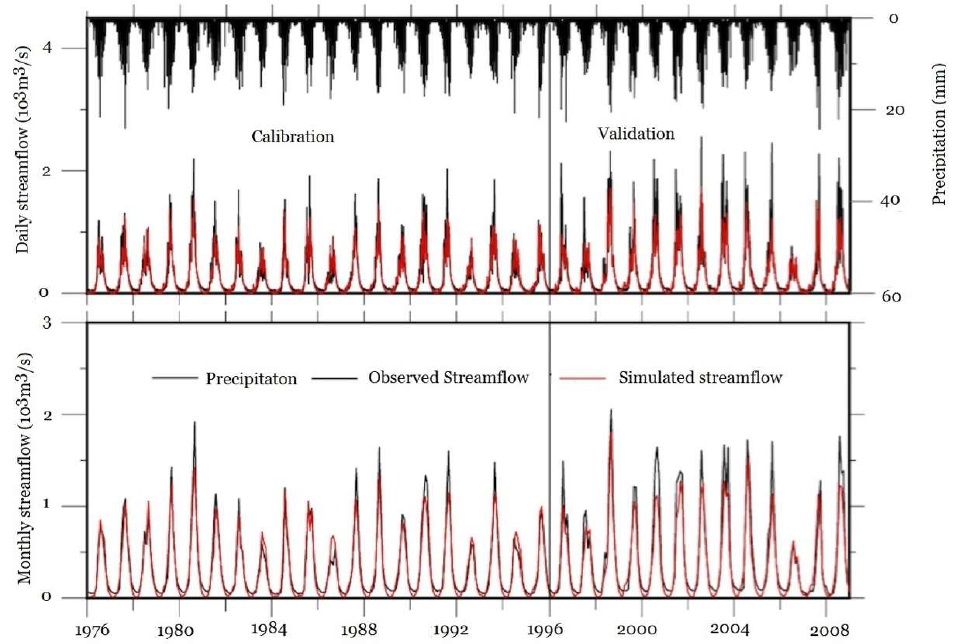
Figure 8. Comparisons between simulated and measured streamflow at daily and monthly time steps. Table 7. Evaluation results of precipitation of the time series.